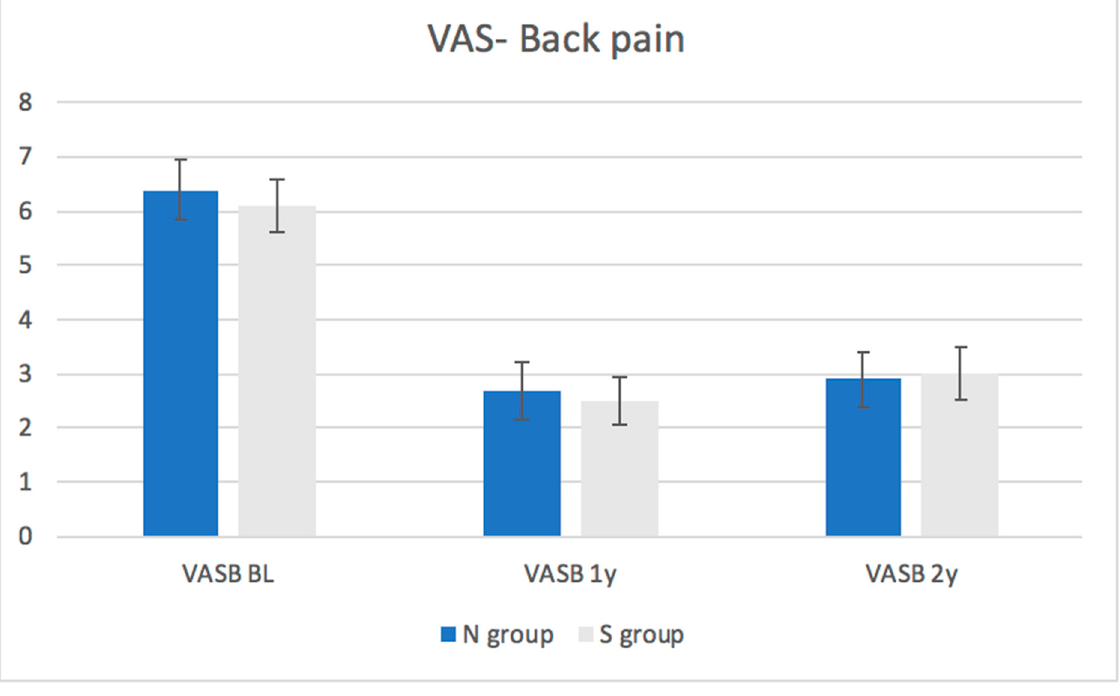
Figure 3. Changes in visual analogue scale for leg pain in each group throughout the follow-up period. Table 3. Changes in the Oswenstry Disability Index (ODI) on the visual analogue scale (VAS) for back pain within each group throughout the follow-up period. Baseline